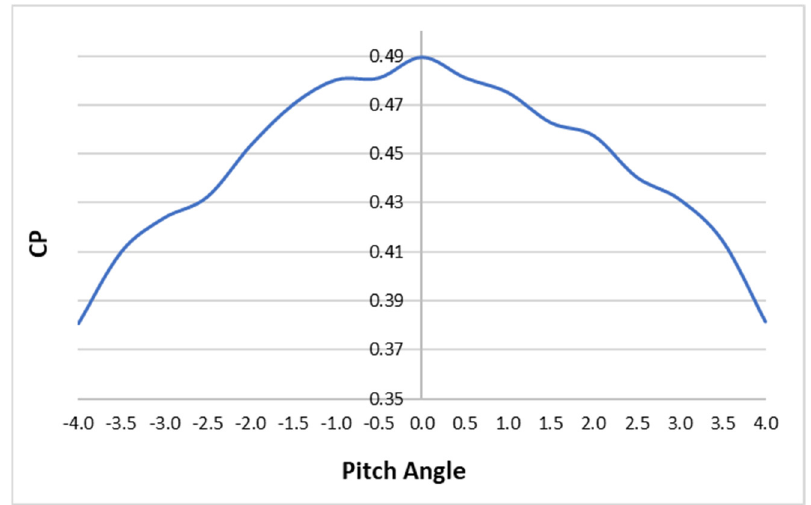
Figure 9. Coefficient of power vs. blade pitch angle. Figure 10. Coefficient of power vs. blade pitch angle.